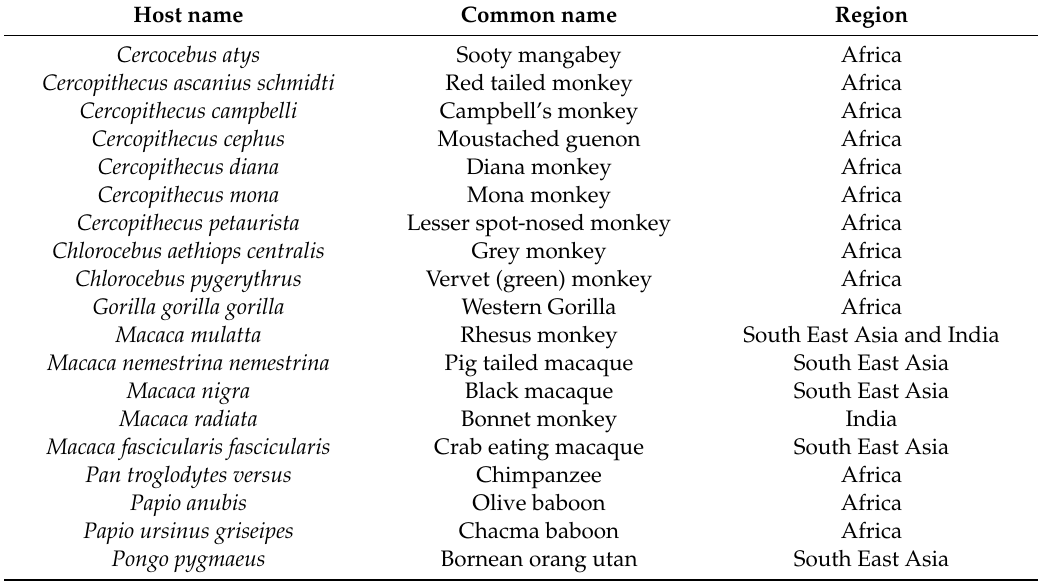
Table 1. Reported non-human primate hosts of Ternidens deminutus and their geographic